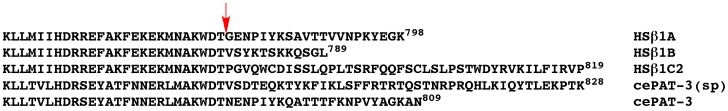
Sequences of the PAT-3 cytoplasmic tails.Wild type and mutant PAT-3 tails are compared to human β1A, β1B, and β1C cytoplasmic tails. Location of intron 7 is indicated by the red arrow.